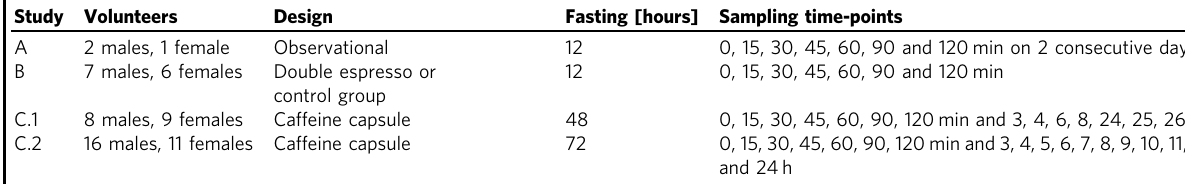
Table 1 Overview of the three studies discussed in this